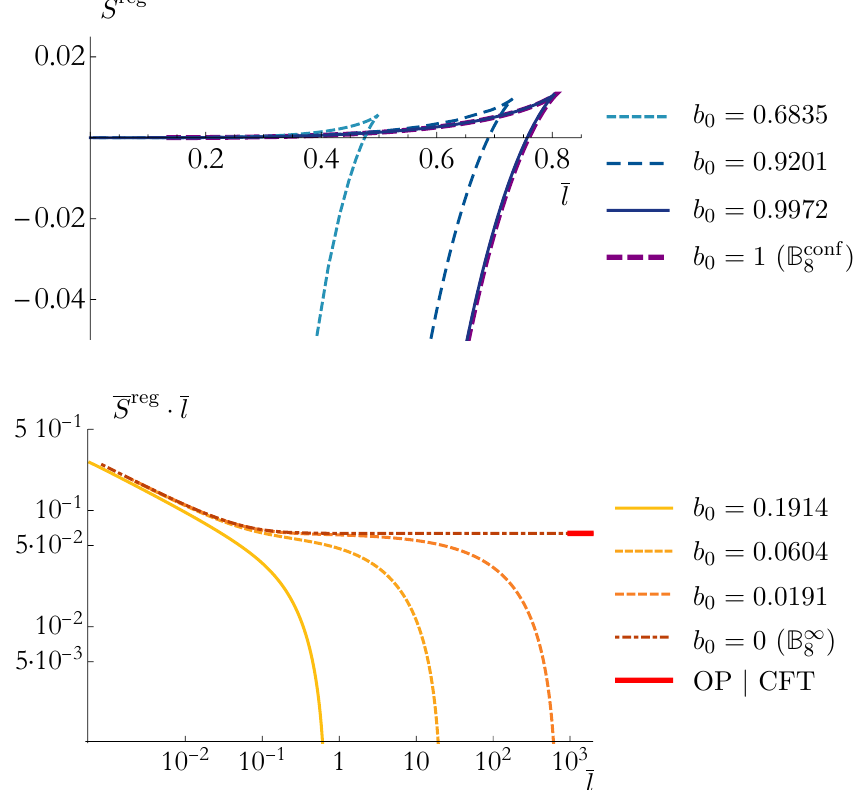
Figure 10. (Bottom) Entanglement entropy of a single strip (multiplied by width l ) as we dial the parameter b to zero. In all cases for non-vanishing b 0 to the case b = 0 where we find precisely the CFT result. Notice, that closer the RG flow passes 0 the OP fixed point, the wider the entanglement plateau, before the entanglement entropy plunges. (Top) Entanglement entropy of a strip as we increase b theory. Note that for the penultimate value for b